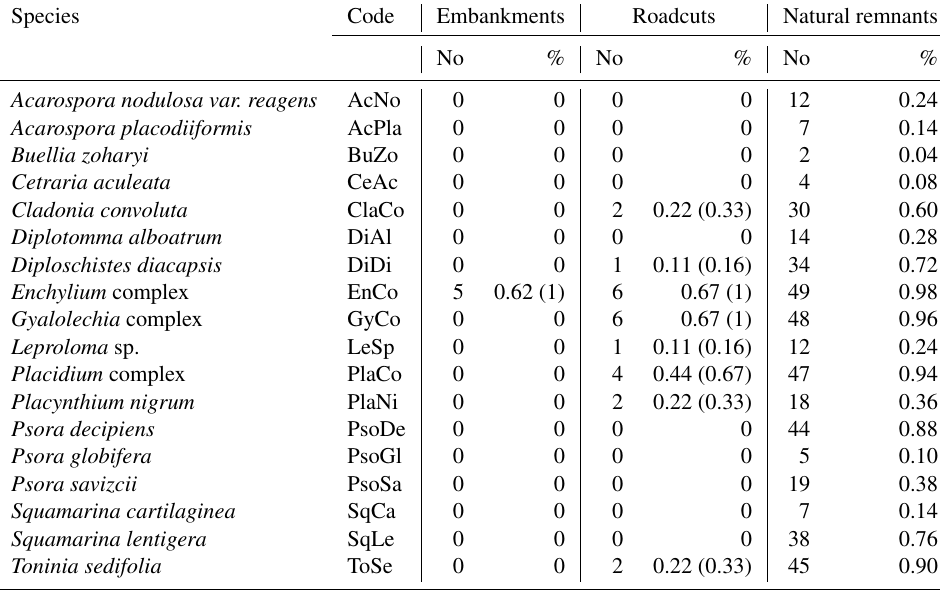
Table 1. Biocrust species codes and frequency as number and percentage of plots at each scenario. For roadcuts and embankments, two percentages are presented: the first is relative to the total number of plots for each scenario, and the second is relative only to the number of plots where biocrusts were present, in brackets.